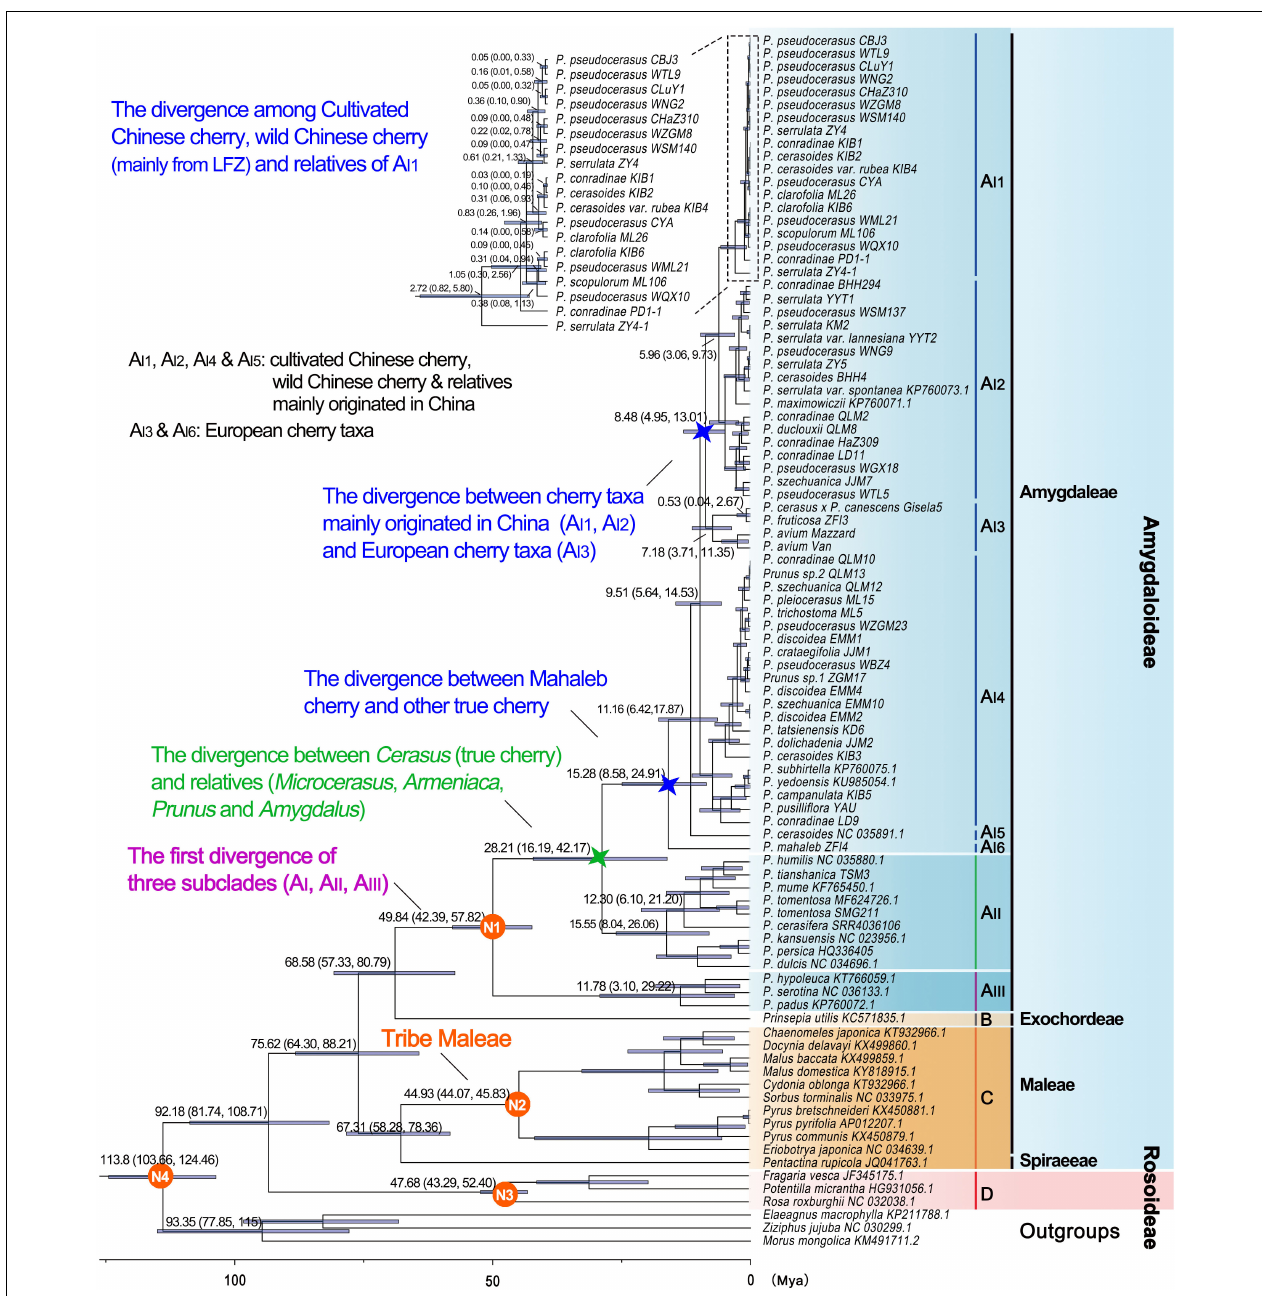
FIGURE 4 | Divergence times of Rosaceae crops based on pruned PWGD. Position of the calibration points N1, N2, N3, and N4 were marked within the tree. Median values and 95% highest posterior density (HPD) were shown next to major branches. The clades A I1 -A I6 , A II , A III , B, C, and D correspond to those in Figure 3 . The divergence between Cerasus (true cherry) and other relatives ( Microcerasus , Armeniaca , Amygdalus, and Prunus ) was marked with green star, and the divergence between European cherry taxa ( Prunus mahaleb , Prunus avium , Prunus fruticosa , and Prunus cerasus × Prunus canescens ) and other true cherries were marked with blue